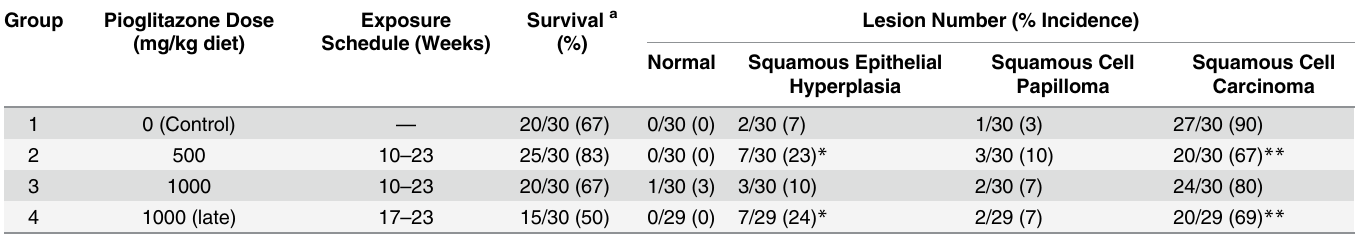
Table 4. Influence of Pioglitazone on Survival and Incidence of Preneoplastic and Neoplastic Oral Lesions in NQO-Treated F344 Rats. Group Pioglitazone Dose (mg/kg diet)